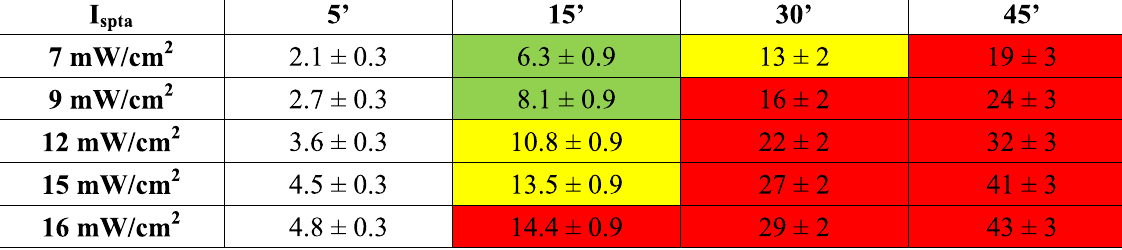
Table 2. Sonication dose values calculated with respect to the treatments carried out on HaCaT cells and expressed in J/cm 2 ; background colours correspond to the observed biological effects: no effects (white), membrane sonoporation (green), sonoporation + loss of viability (yellow), sonoporation + loss of viability including significant necrosis and apoptosis + inflammation